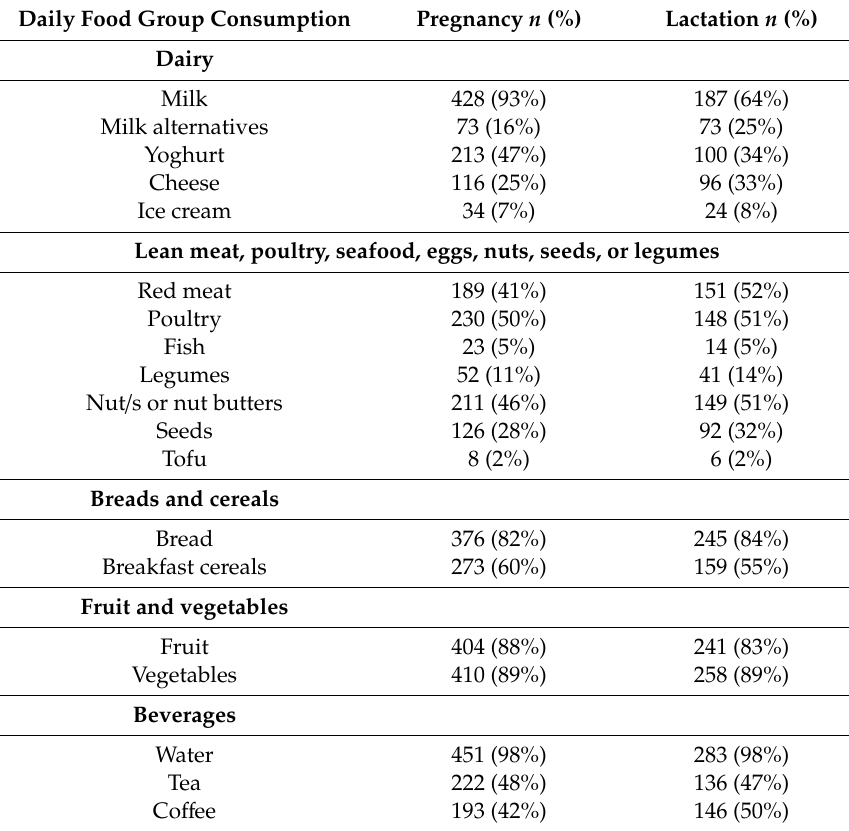
Table 2. Foods and beverages consumed daily during pregnancy and lactation.